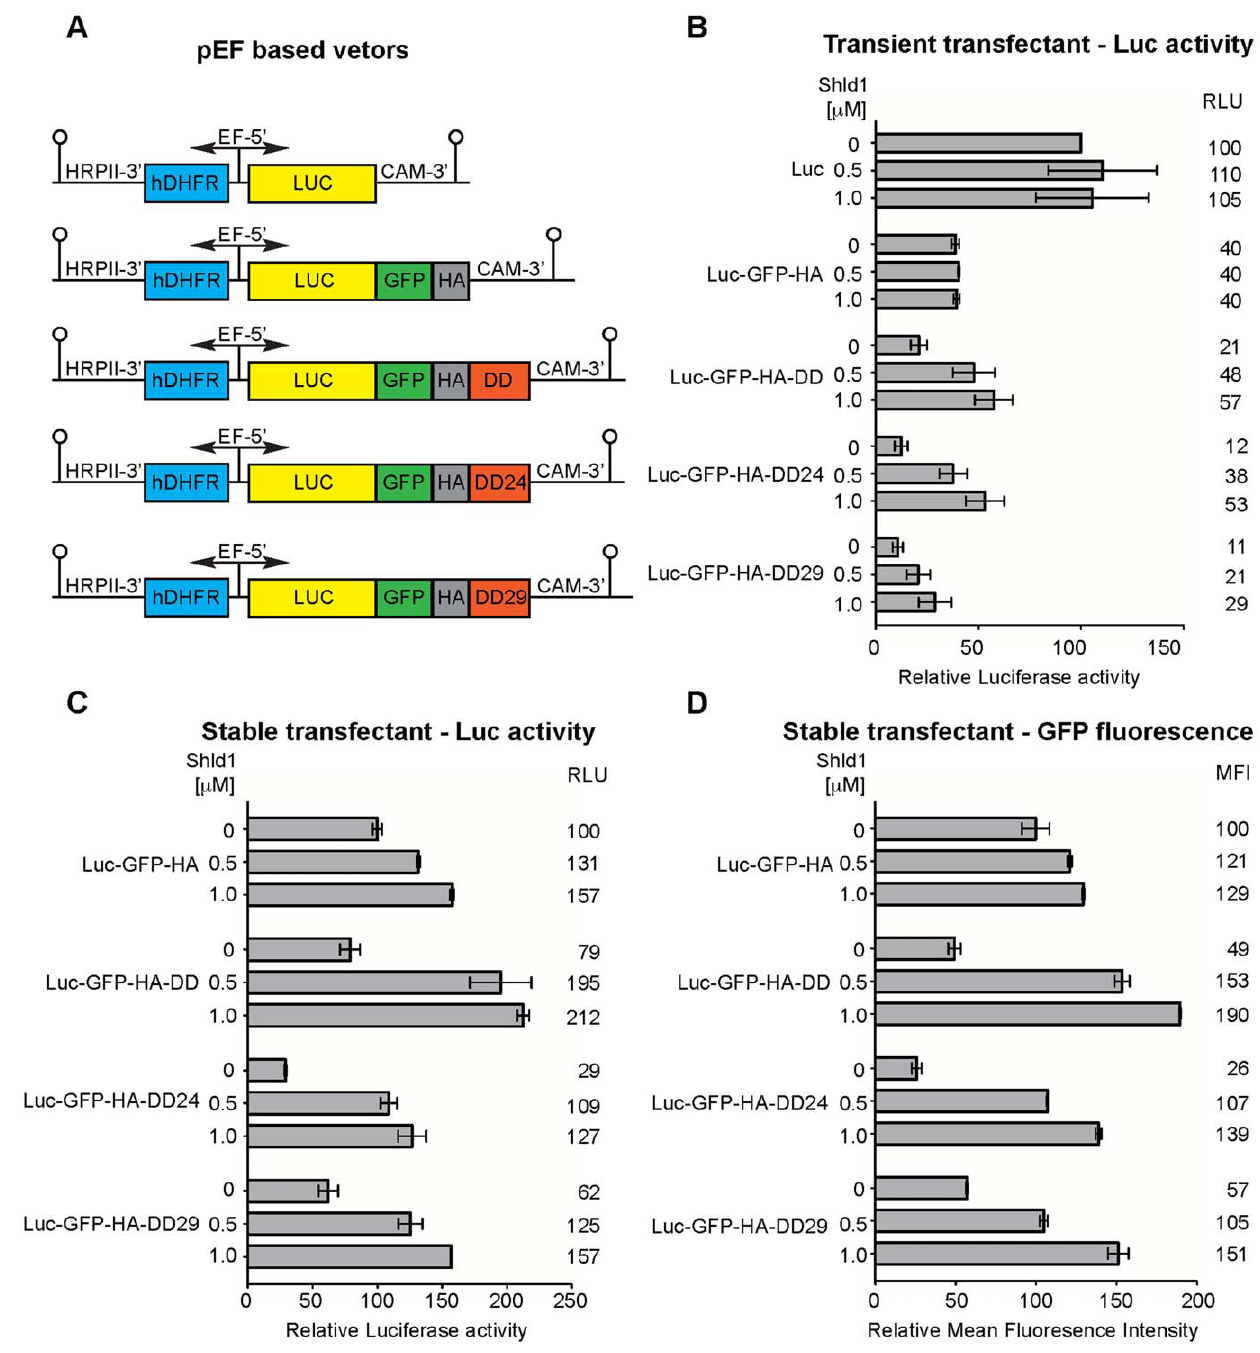
Figure 2. Regulation with C-terminal DD. (A) Maps of inducible expression vectors. (B) To measure expression in transiently transfected parasites ring stage parasites were transfected and the indicated Shld-1 concentrations were added the next day and maintained for 24 hours. Luciferase expression is represented relative to the positive control pEF-Luc kept without Shld-1. Results indicate the average of 4 experiments and error bars show the standard deviation. (C) Luciferase activity on stably transfected parasites. Ring stage parasites of stable transfected lines were incubated for one day with the indicated Shld-1 concentrations. The measured luciferase activity was normalized by the number of parasites and expressed as percentages to the control line 3D7 transfected with Luc-GFP kept without Shld-1. (D) GFP fluorescence of the parasites described in (C) was measured by flow cytometry and is expressed relative to the control line Luc-GFP kept without Shld-1. RLU – relative light units, FI – fold induction of reporter expression, MFI – mean fluorescence intensity. doi:10.1371/journal.pone.0040981.g002 29% and 30% when cultures were kept on 0.5 m M and 1.0 m M was poorly reverted by Shld-1, 18% and 16%, respectively ( , 1.5– Shld-1, respectively (3 fold induction). The triple mutant DD24 1.6 fold induction). DD29 was an even more efficient destabiliser, destabilized luciferase as efficiently as DD, but reporter activity reducing reporter activity even further to about 6%, but similarly